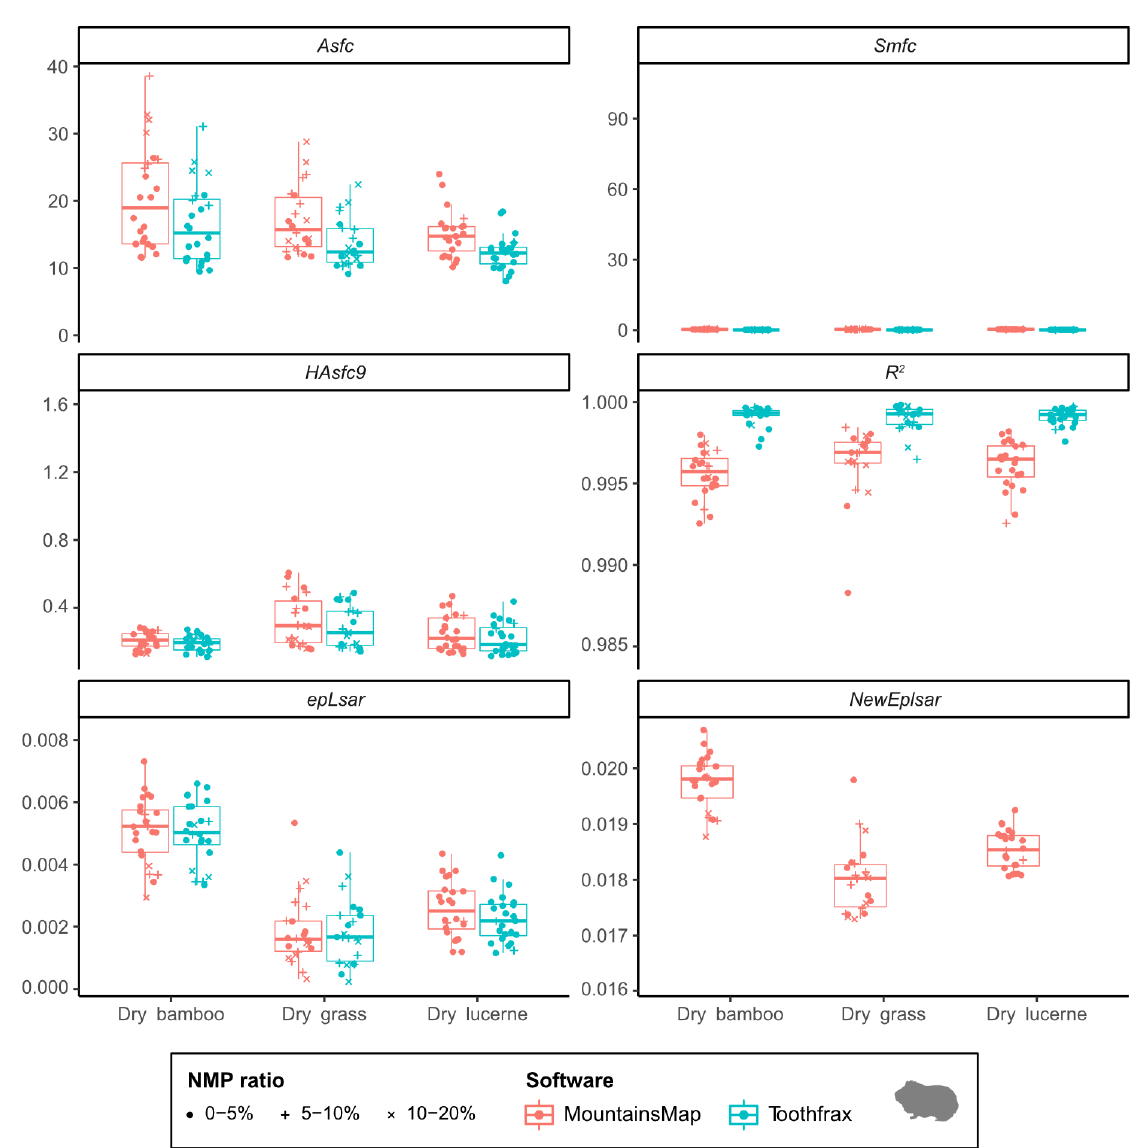
Fig. 2. Boxplots of the SSFA parameters for the guinea pig dataset. See Fig. 1 for details on boxplots and abbreviations. See text for details on surface parameters and treatments. Guinea pig silhouette from Wikimedia Commons (Flappiefh, CC BY 3.0